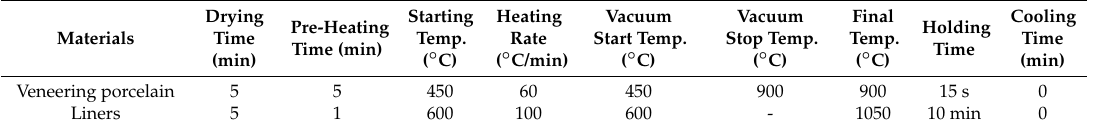
Table 5. Firing parameters of the veneering porcelain (Ceramco PFZ) and liners (HeraCeram Zr-Adhesive and ELs)